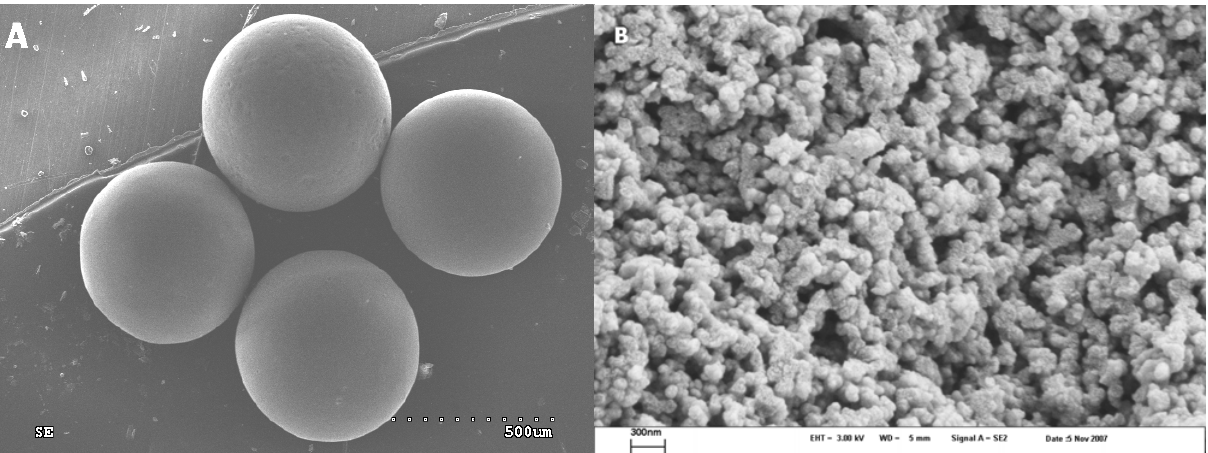
Figure 3. SEM micrograph of the SCN AC: (a) spherical particles forming the SCN. (b) ESEM micrograph of surface morphology of the SCN AC spherical